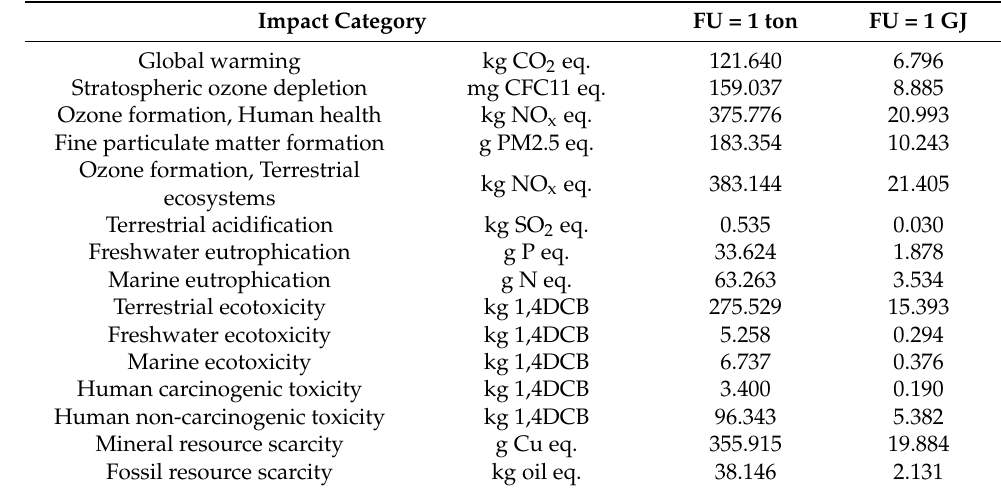
Figure 3. Contribution analysis for miscanthus pellet production. Table 6. Environmental impact of 1 ton of miscanthus pellet and for 1 GJ of Lower Heating Value (LHV).